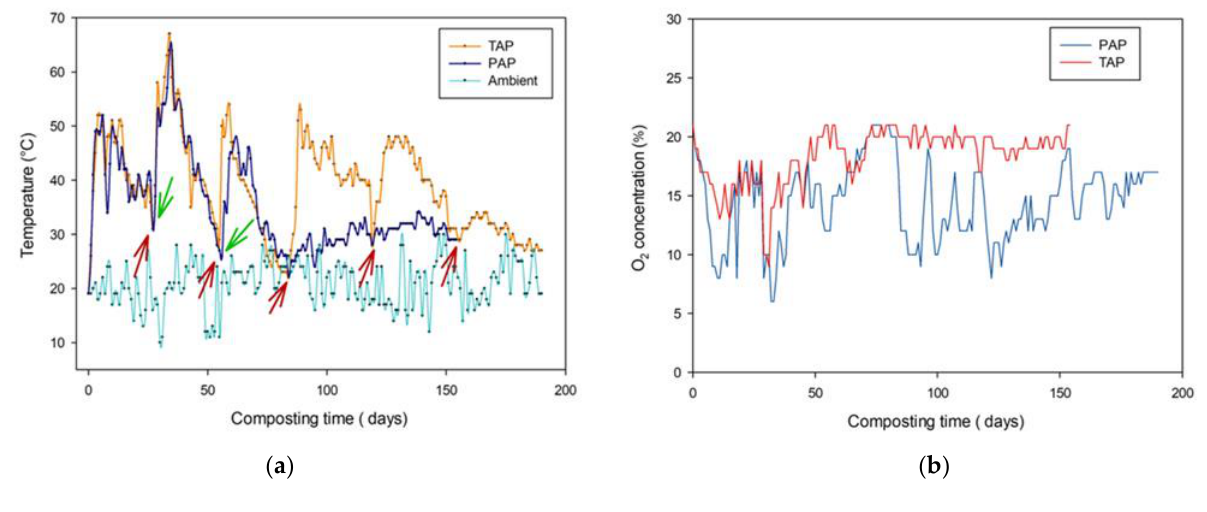
Figure 2. ( a ) Temperature evolution during the composting process. TAP: turning aeration pile; PAP: passive aeration pile. The red arrows indicate the days on which the turnings were carried out in the TAP and the green arrows the days on which the turnings were carried out in the PAP. ( b ) O 2 concentration evolution during the composting process. Table 6. Evolution of the main parameters during the composting